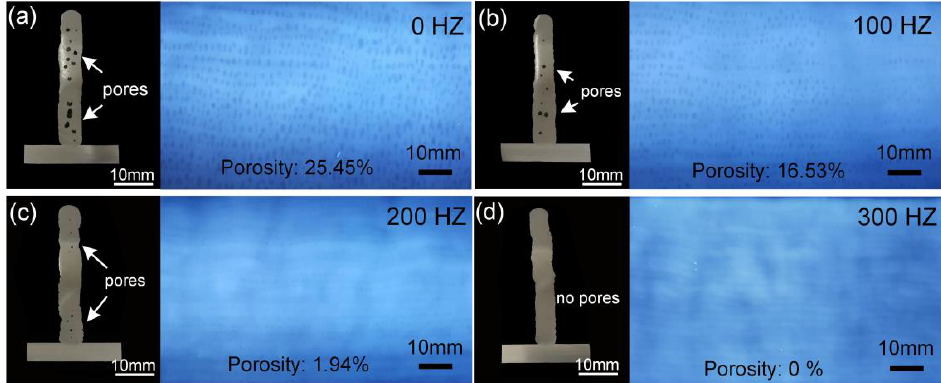
Figure 4. The longitudinal cross-section and the transverse X-ray NDT results of the components.